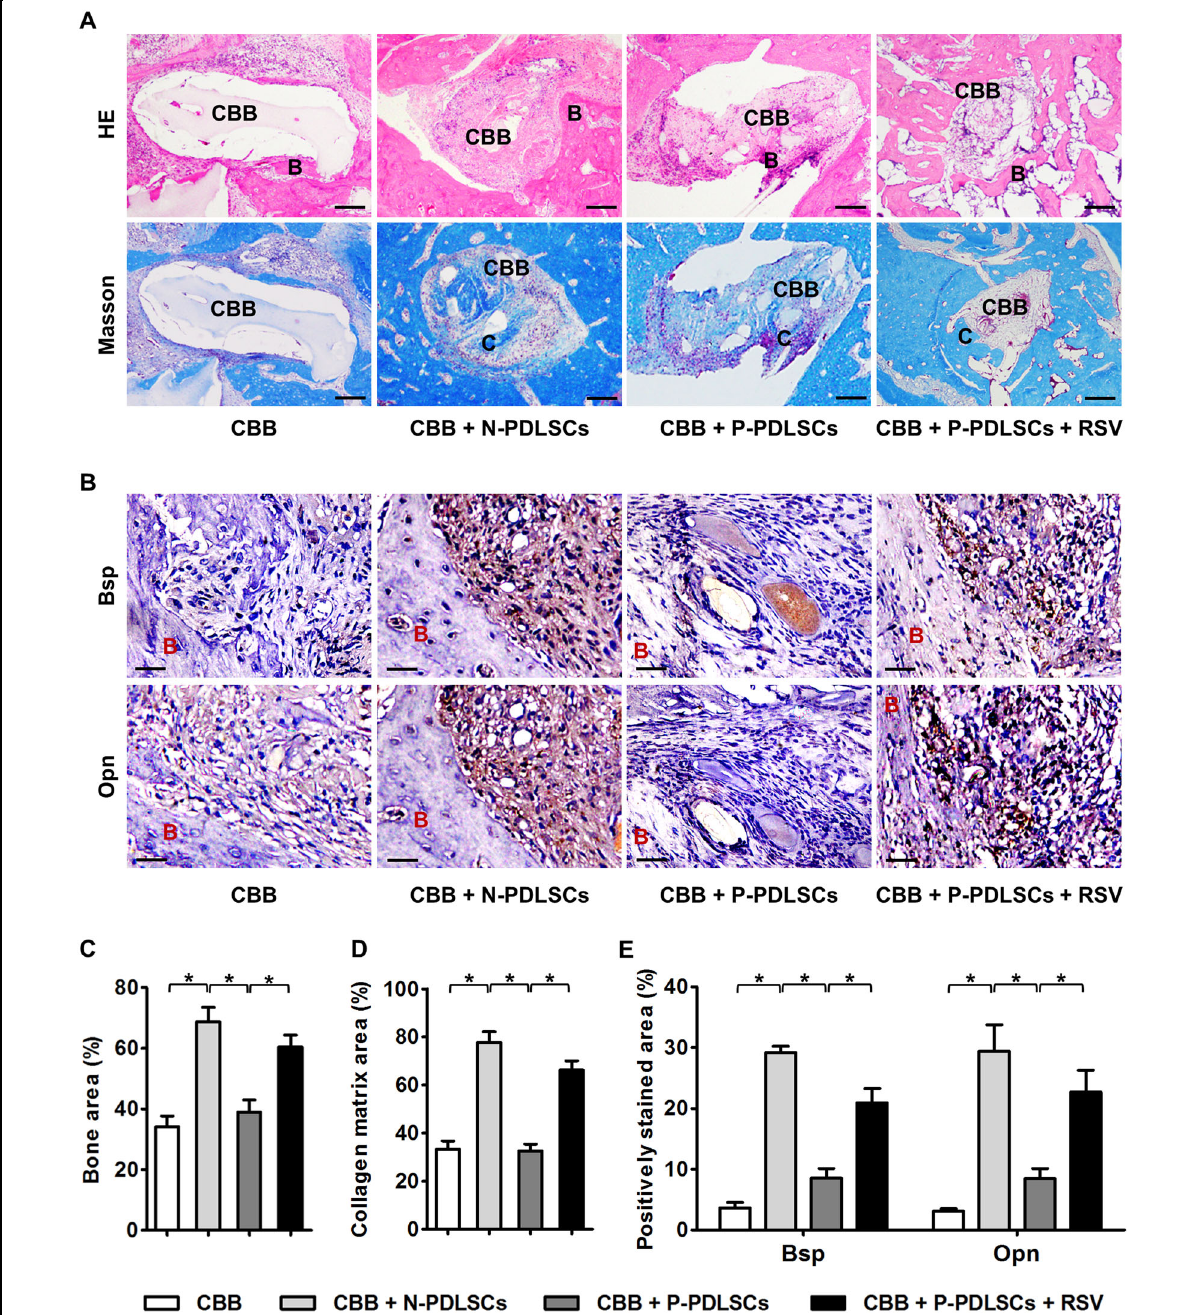
Fig. 6 RSV treatment enhanced the periodontal regeneration and osteogenesis of P-PDLSC aggregates in vivo. a Histological analysis of periodontal bone regeneration (denoted by B) and collagen bone matrix deposition (denoted by C) of PDLSC aggregates by HE (top) and Masson ’ s trichrome staining (bottom). b Immunohistochemistry analysis of the osteogenic marker genes bone sialoprotein (Bsp) and osteopontin (Opn). c – e Statistical analysis showed that P-PDLSC aggregates regenerated less bone and produced less collagen matrix in periodontal defects and demonstrated weaker osteogenic potential, which could be improved by RSV treatment. RSV was applied at 10 nM throughout the in vitro treatments. n = 6 per group. The data represent the mean ± SD. * P <